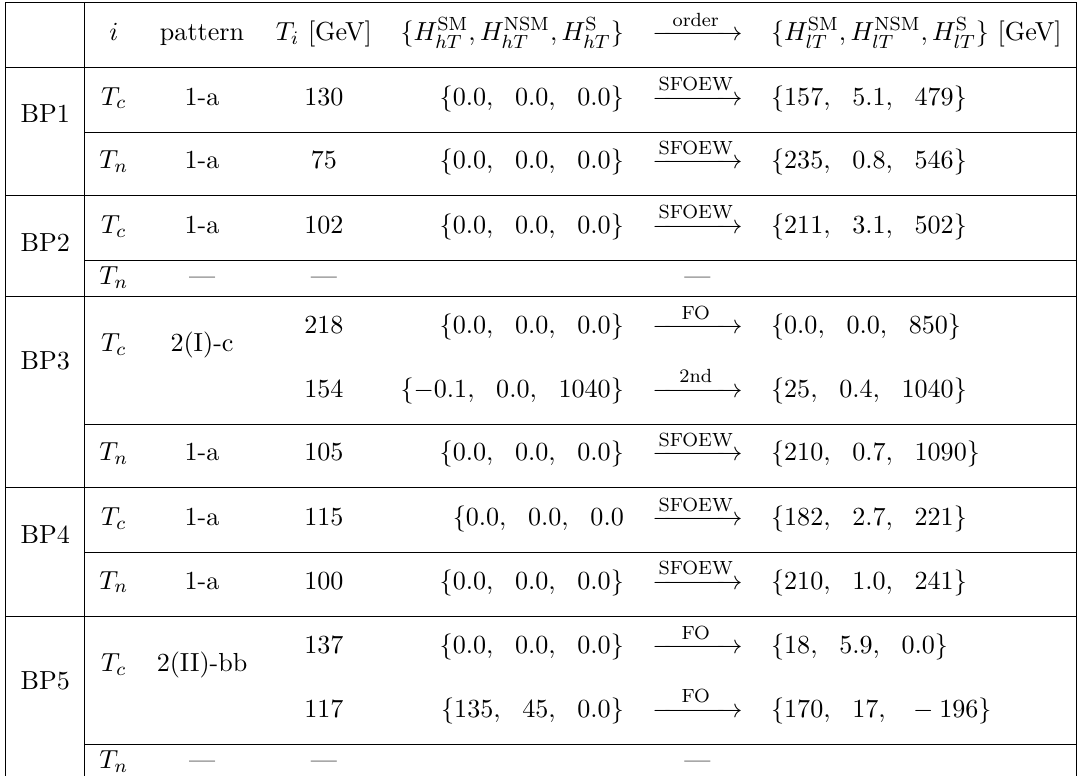
— — Table 3 . Information detailing the phase transition behavior of our benchmark points. Note that for each benchmark point, the values listed in the rows marked “ T ” contain the phase transition c patterns suggested by the critical temperature calculation, while the rows labeled “ T ” show the n phase transition behavior we obtain from the nucleation calculation. See section 2.4 for the short- hand notation we use for the phase transition patterns. In the right-most column, we also denote the order of the transition(s) — “SFOEW” denotes a strong first order electroweak phase transition as defined in section 2.4, “FO” denotes a transition that is first order but not a SFOEWPT, and “2nd” denotes a second order